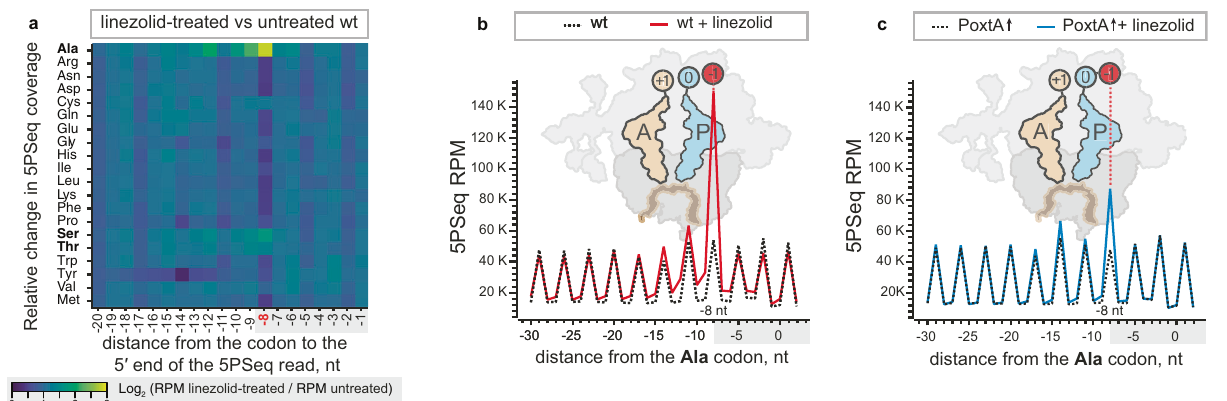
Fig. 2 Context-dependent ribosomal stalling induced by linezolid is countered by PoxtA. a A heatmap of log 2 -relative change in the 5Pseq coverage of wild-type E. faecalis upon linezolid treatment. The distance (in nucleotides, nt) from the 5 ʹ of the sequenced mRNA fragments to synonymous codons encoding a speci fi ed amino acid is indicated on the x axis. The 0 nt position corresponds to the fi rst nucleotide of the codon. Dark blue signi fi es decreased 5PSeq coverage upon linezolid treatment, yellow signi fi es increased coverage upon linezolid treatment. A speci fi c increase in the 5Pseq coverage associated with synonymous codons located at – 8 nucleotides is indicative of a ribosomal stall with the corresponding amino acid in the − 1 position of the nascent chain, as illustrated schematically in panels b and c (ref. 33 ). b , c Metagene analysis of 5Pseq libraries aligned to alanine codons. Linezolid-induced ribosomal stalling results in a speci fi c increase in 5Pseq read counts 8 nt upstream of alanine codons, indicating a ribosomal stall with alanine residues in the − 1 position (see schematics). Samples were prepared with E. faecalis harbouring the empty pCIE spec vector ( a , b ) or upon poxtA expression ( c , blue line), with and without linezolid treatment. Exponentially growing cells were treated with 4 μ g/mL linezolid ( fi nal concentration) 10 min before harvest. All analyses were performed on pooled datasets from three biological